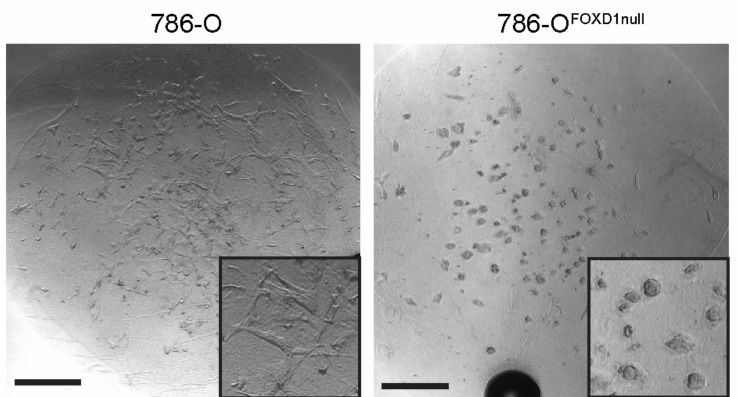
Figure 5. 786-O 3D growth. 786-O ( left ) or 786-O FOXD1null ( right ) 3D cultures grown in fibrin/Tumor ECM. Inset images show higher magnification to detail structural differences in cell colony growth. Scalebar = 500